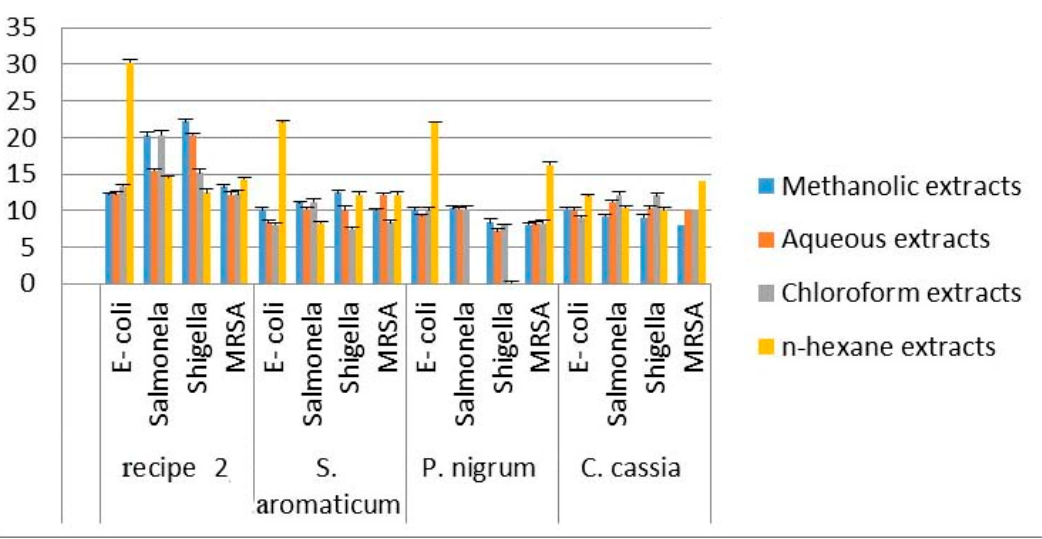
Figure 3. Antibacterial activities of methanol, aqueous chloroform and n-hexane extracts of the S. aromaticum (flower buds), P. nigrum (seeds), C. cassia and recipe 2. Each column represents the mean value of three independent replicates and the error bars indicate standard deviation.